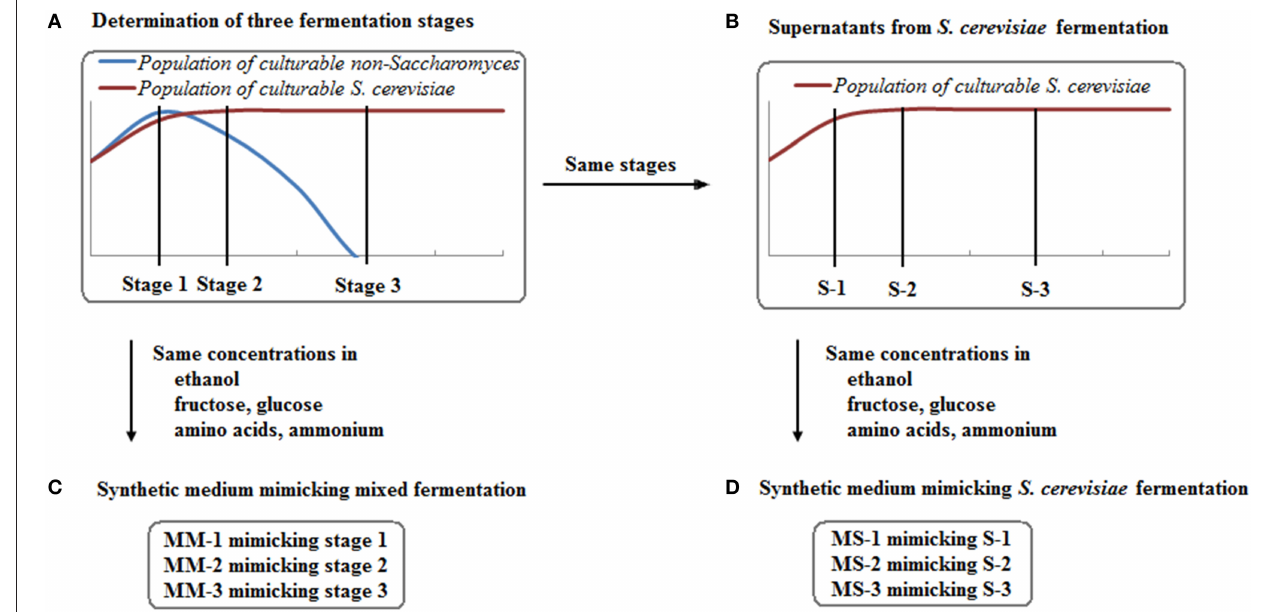
FIGURE 1 | Experimental design for setting up three fermentation stages (A) and preparing three types of synthetic media (B–D).